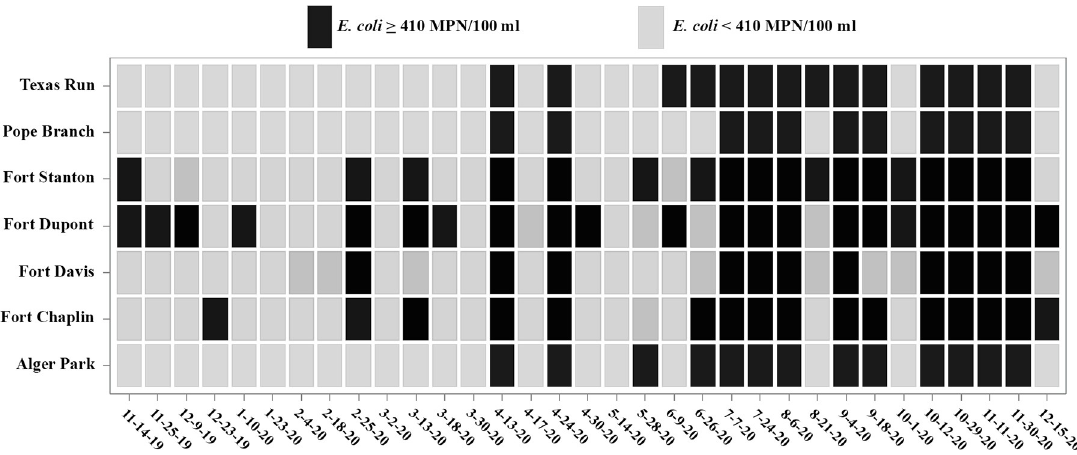
Fig 3. Samples that exceeded the local single sample maximum of E . coli 410 MPN/100